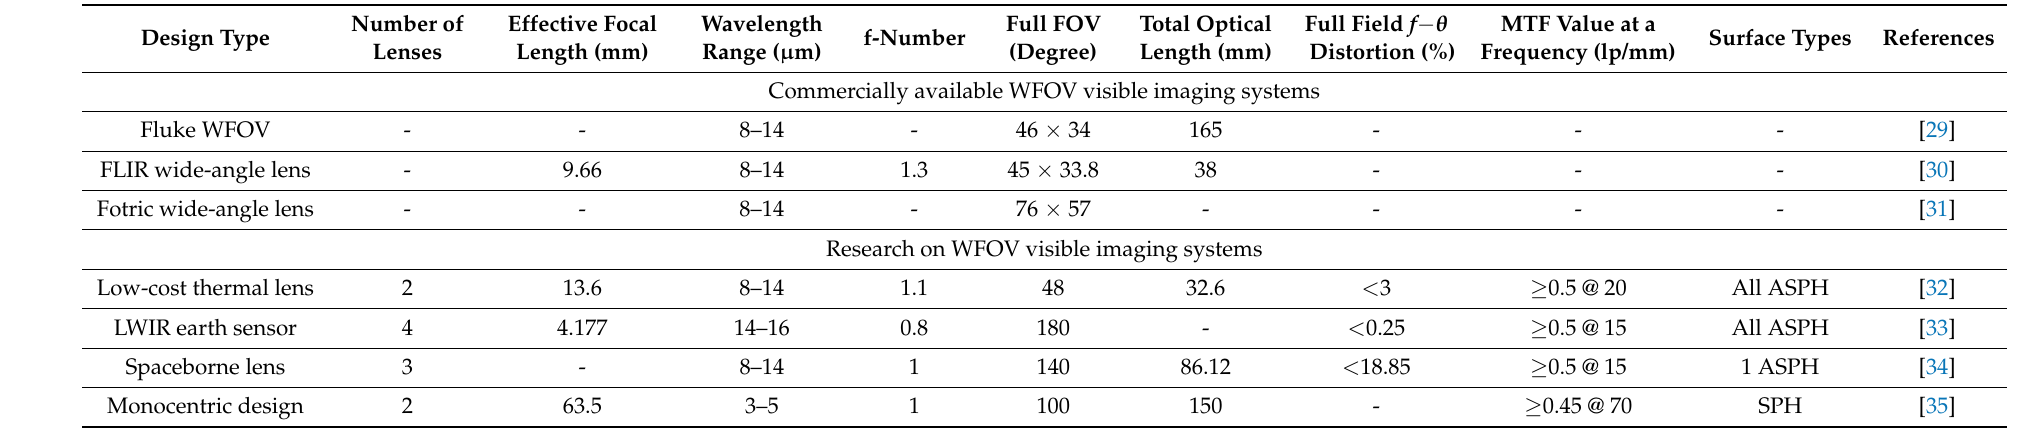
Table 3. Overview of the state-of-the-art thermal imaging